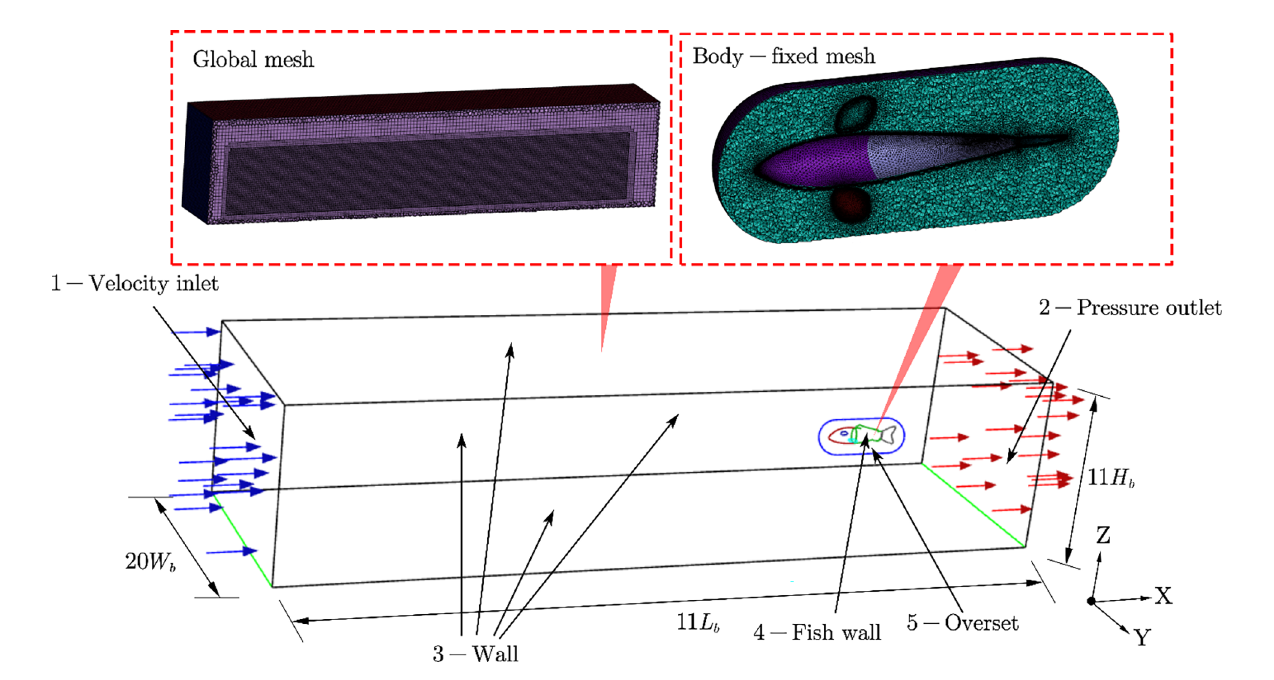
FIGURE 6 Meshes and boundary